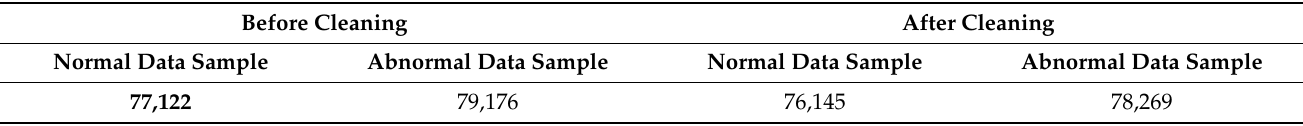
Table 2. Statistics of the number of samples before and after cleaning.